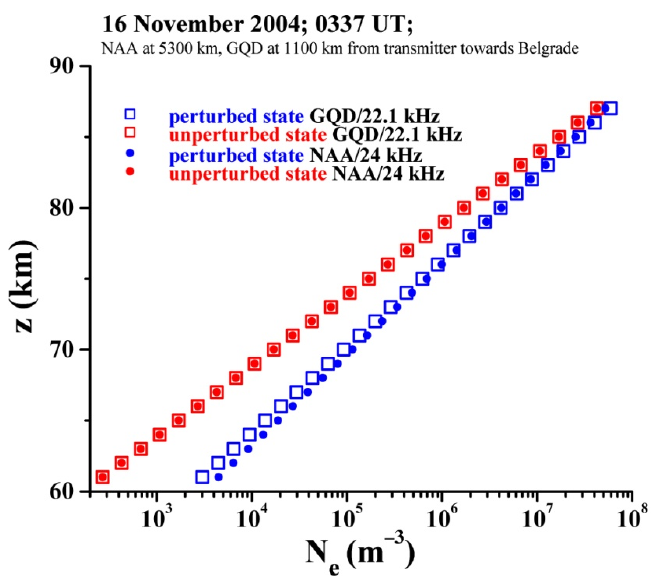
Figure 10. Electron density N e ( z ) height profiles for GQD (at reflection height 85.8 km) and NAA (at reflection height 86 km) signals, calculated for altitude range 60–90 km, for 16 November 2004, at 03:37 UT, in the area of the most prominent electron density change along GCPs at a location approximately 1100 km looking from Belgrade towards both transmitters. The unperturbed state for GQD signal is given in red hollow squares, the perturbed state for GQD signal is given in blue hollow squares, unperturbed state for NAA signal is given in red solid circles and perturbed state for NAA signal is given in blue solid circles.